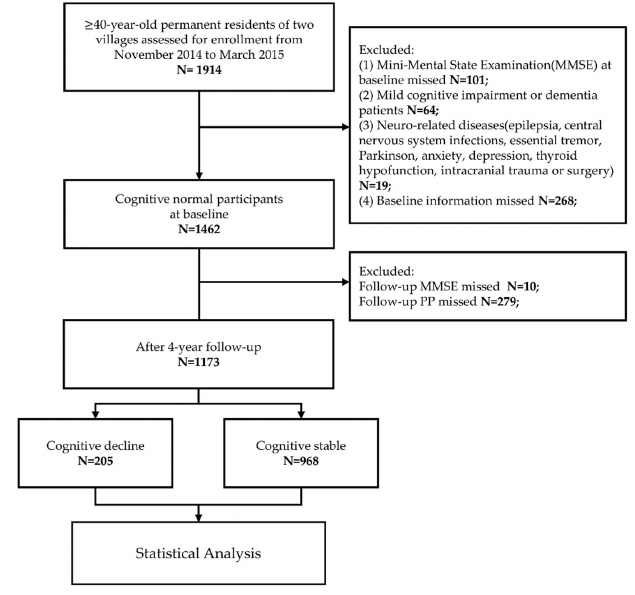
Figure 1. Flow chart of research design.